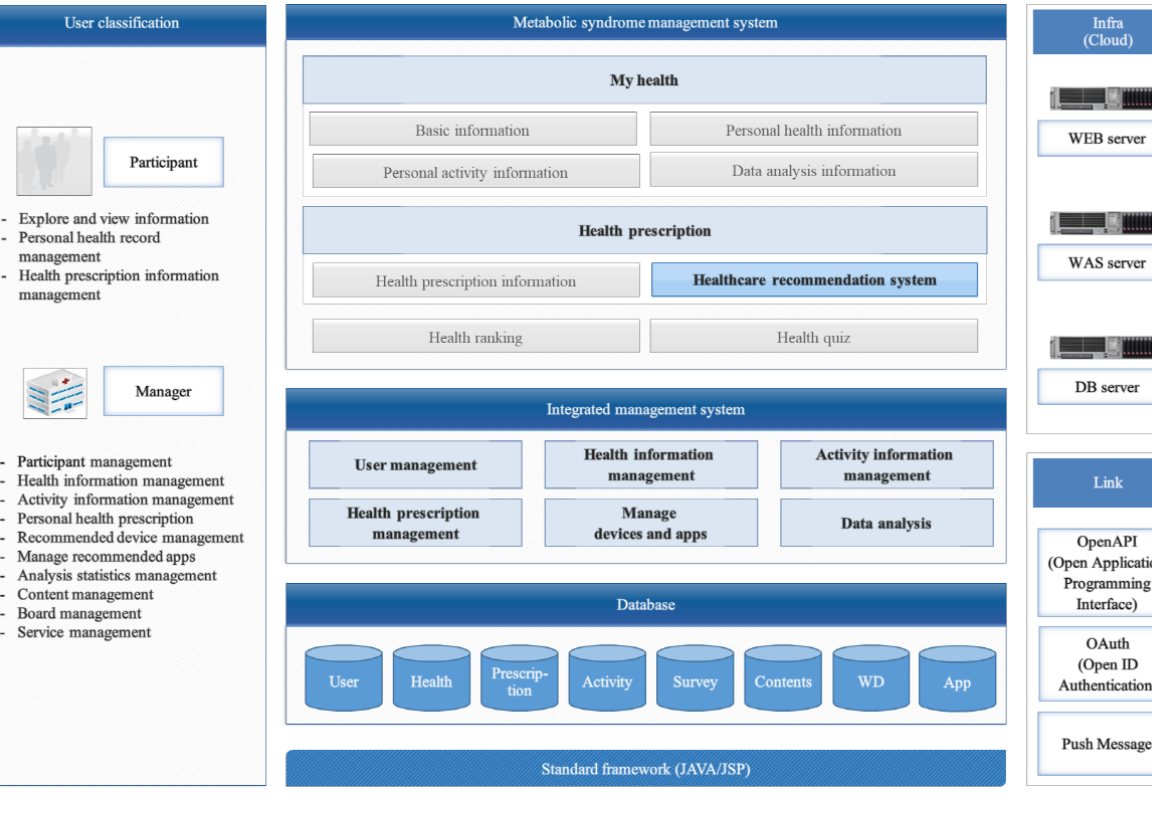
Figure 4. Entity-relation diagram of e-Motivate4Change